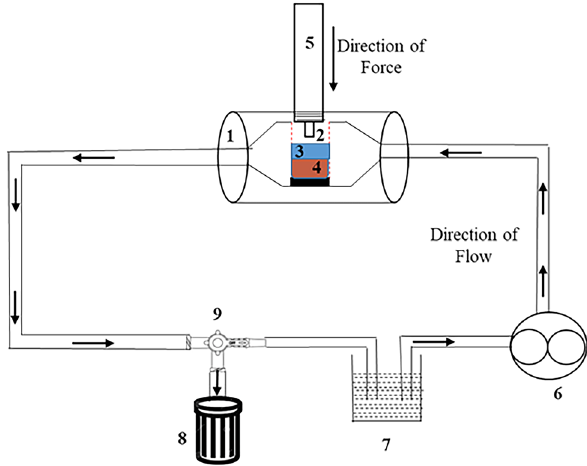
Figure 2. Schematic view of the setup of one complete specimen chamber in an ex-vivo bioreactor system. 1. Specimen chamber, 2. Polycarbonate holder, 3. Fiber Mesh metallic Scaffold, 4. Bone Core, 5. Pneumatic Actuator, 6. Peristaltic pump, 7. Media container, 8. Waste container, 9. Three-way